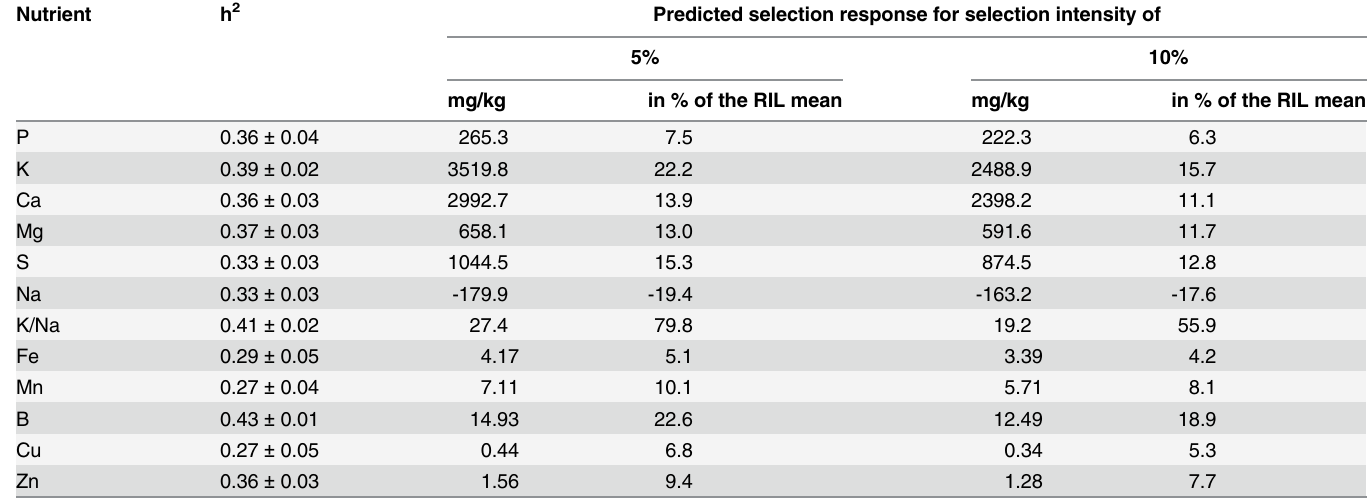
Pearson correlation coefficients for leaf macro-, micro-nutrient and Na concentrations and K/ Na ratio are given in Table 4. Significant simple correlations existed in 44 of 66 pairs of nutrient combinations with the majority of them being positive. Interrelationships were more common between macronutrients, Na and K/Na ratio than between them and micronutrients (Table 4). For the interrelation of macronutrients, Na and K/Na ratio, nine pairs were positive with the strongest being among Ca, Mg and S, and between K and K/Na ratio (0.60 to 0.76, P < 0.001), intermediate for Na with Ca, Mg and S, respectively (0.38 to 0.48, P < 0.01), and the weakest for P with K and K/Na ratio, respectively (0.24 to 0.31, P < 0.05). Seven pairs showed an inverse re- lation with the strongest between Na and K/Na (-0.69, P < 0.001), intermediate for K/Na ratio with Ca and Mg, respectively, and for K with Na (-0.34 to -0.42, P < 0.01), and weakest between Table 3. Estimates of narrow sense heritability (h 2 ) and predicted selection response for five macro-, five micro-nutrient and Na concentrations and K/Na ratio on leaves of the RIL population under two selection intensities based on a combined data analysis over two seasons. Nutrient h 2 Predicted selection response for selection intensity